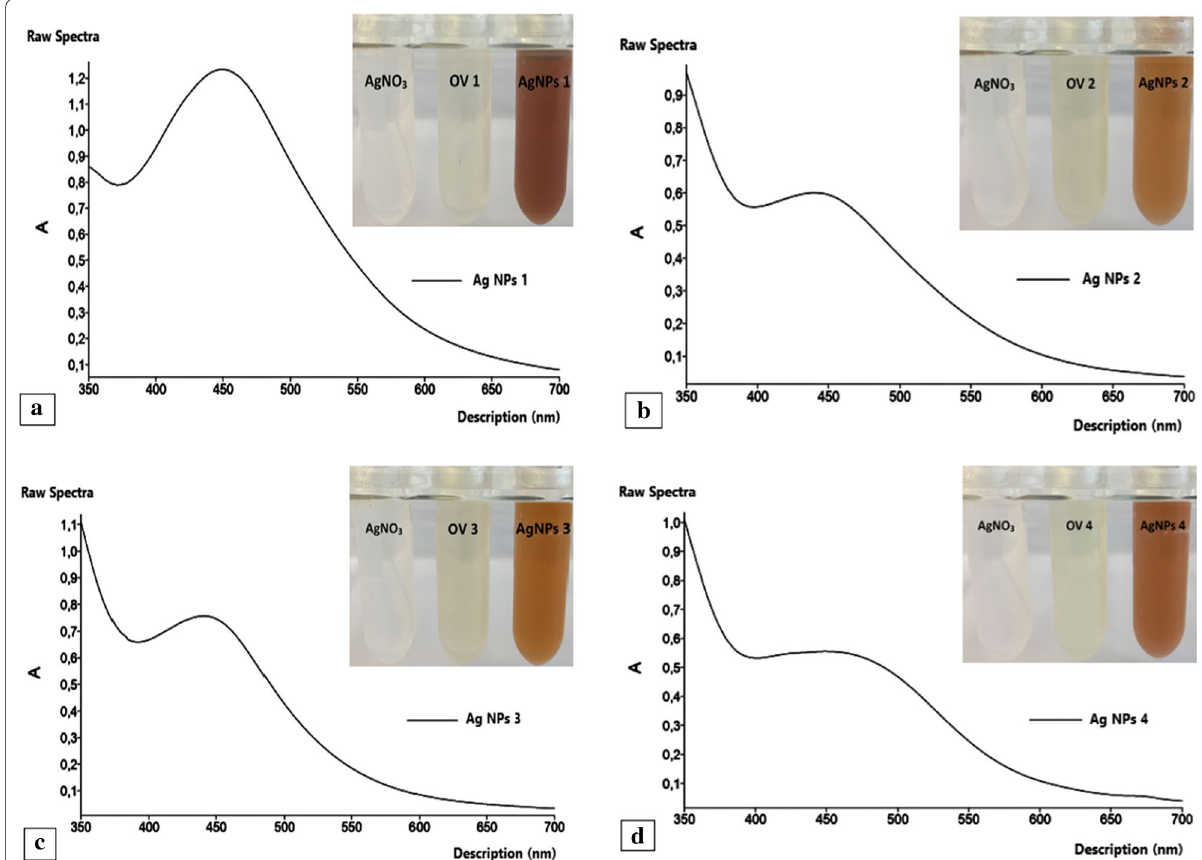
Fig. 3 UV-Vis spectrophotometric analysis of Ag NPs 1 ( a ), Ag NPs 2 ( b ), Ag NPs 3 ( c ) and Ag NPs 4 ( d ). See the